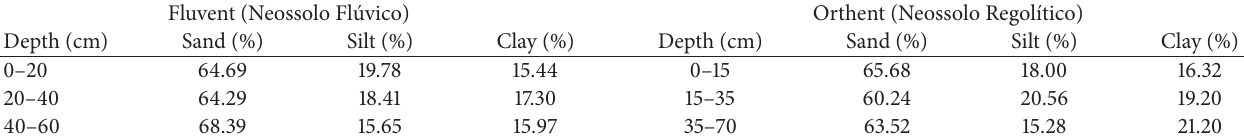
Table 1: Granulometric analysis as a function of depth of the soils studied.